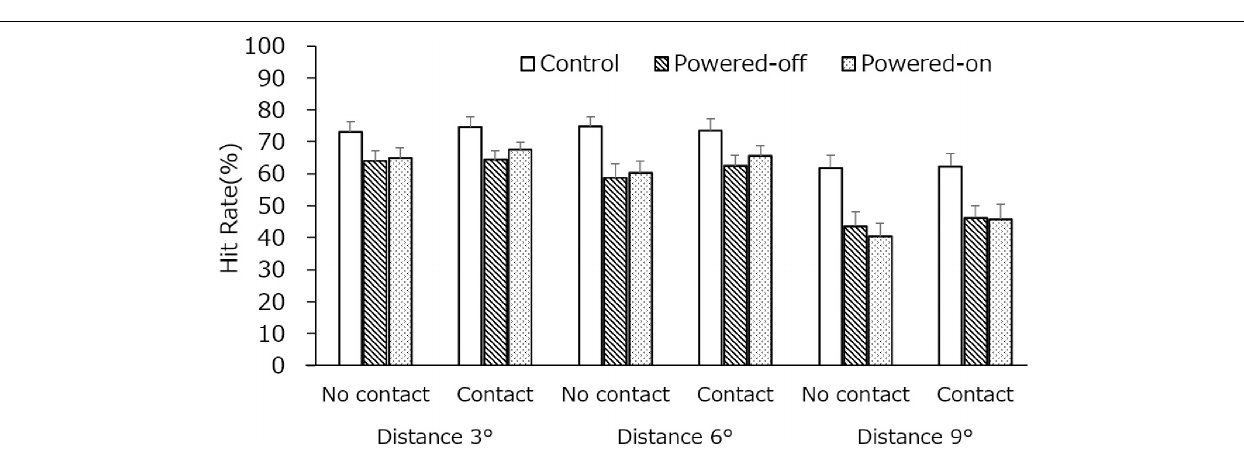
FIGURE 7 | The hit rate of the LCD task in experiment 2. Error bars depict standard error